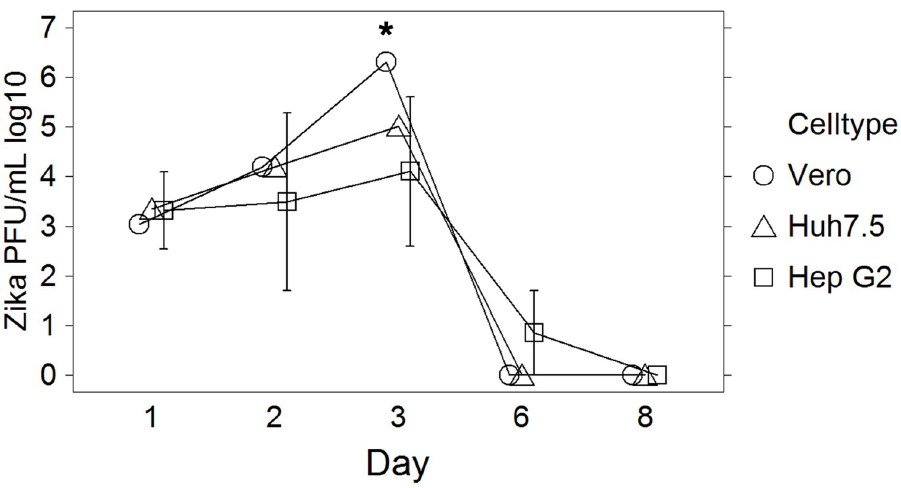
Fig 1. Production of infectious Zika viral particles. In target cell lines over time as measured by plaque assay. PFU/ mL = plaque forming units/milliliter. Error rate for plaque assay is +/- 0.5 log. Asterisks denote data with statistically significant change from baseline.